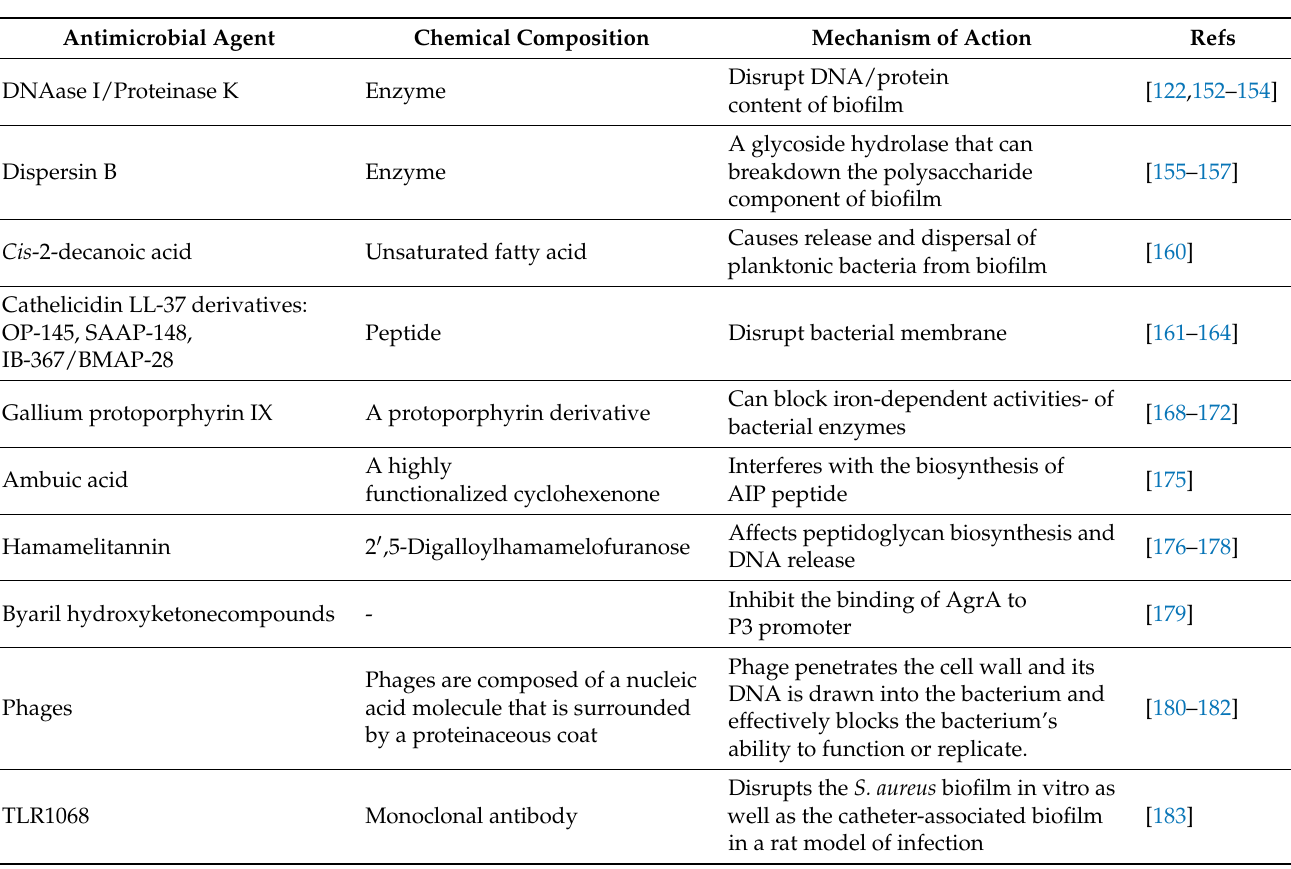
Table 2. List of non-conventional anti-microbial agents used for treating biomaterial-associated S. aureus